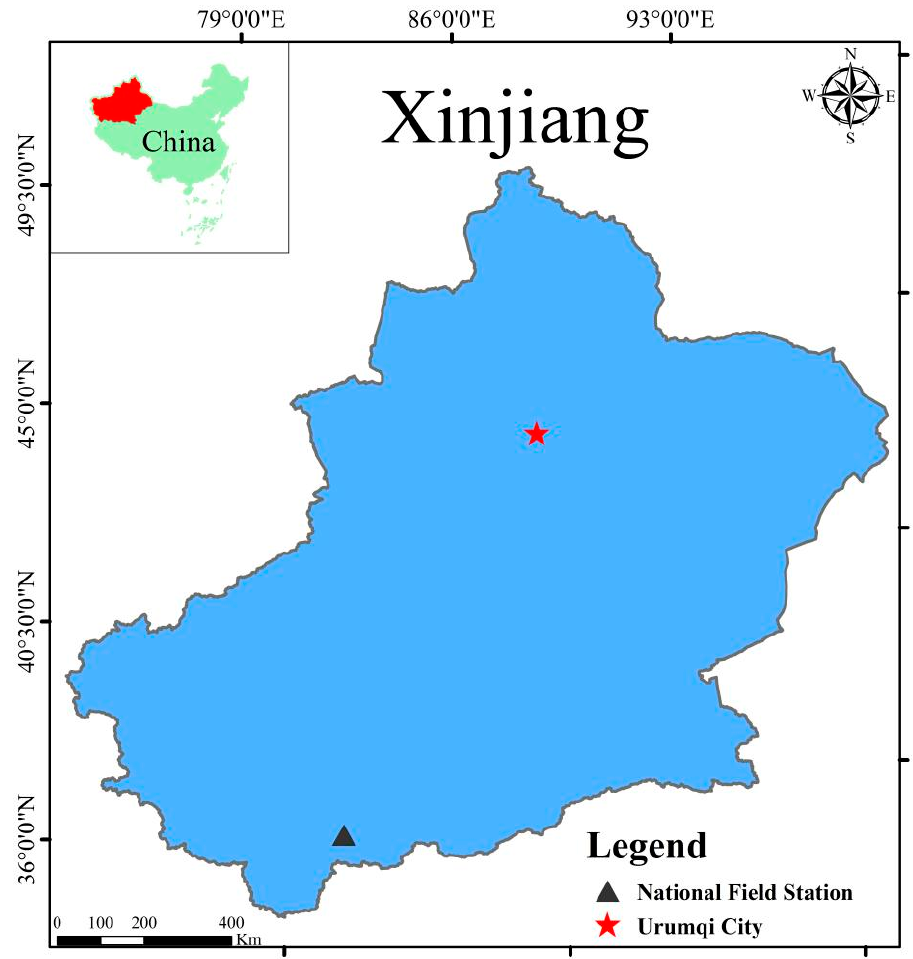
Figure 1. Location of field station .